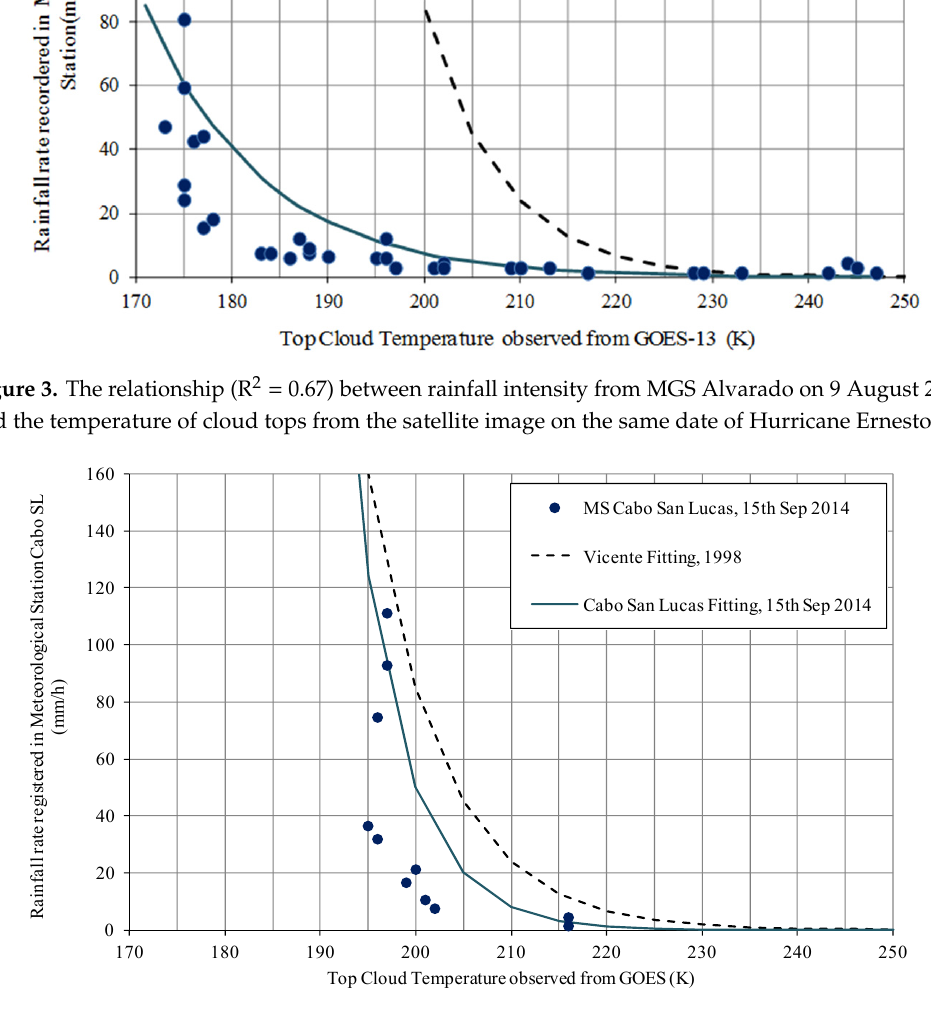
Figure 4. The relationship (R 2 = 0.57) between rainfall intensity from MGS Cabo San Lucas on 15 September 2014 and the temperature of cloud tops from the satellite image at the same date of Hurricane Odile.